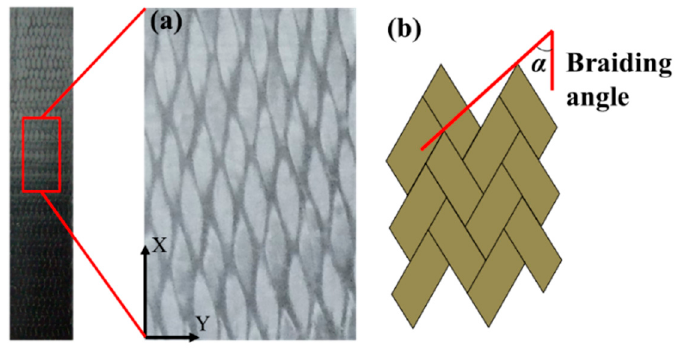
Figure 3. ( a ) The surface of the braided composite and ( b ) the applied braiding angle.